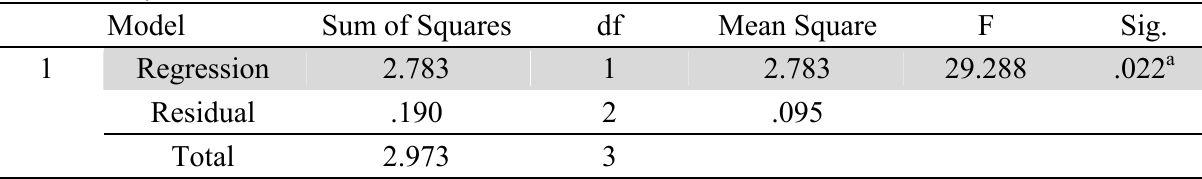
The summary of ANOVA